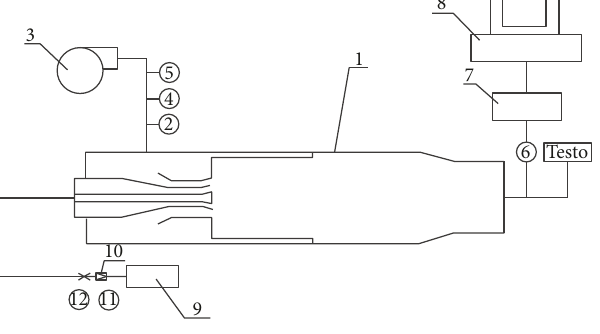
Figure 1: Scheme of the